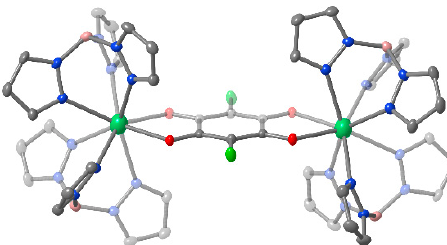
Figure 1. Solid state molecular structure of [{Ln(Tp) 2 } 2 ( μ -Cl 2 An)]·2CH 2 Cl 2 with thermal ellipsoids drawn at a 50% probability level with the exception of lanthanide atoms shown at a 99% probability level. The spring green, blue, red, sundown, vivid lime green, and gray ellipsoids represent Ln, N, O, B, Cl, and C atoms, respectively. Hydrogen atoms and lattice solvent molecules are omitted for clarity.